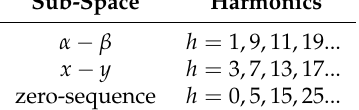
Table 1. Sub-space harmonics mapping for a five-phase machine. Sub-Space Harmonics α − β h = 1,9,11,19... x − y h = 3,7,13,17... zero-sequence h = 0,5,15,25...